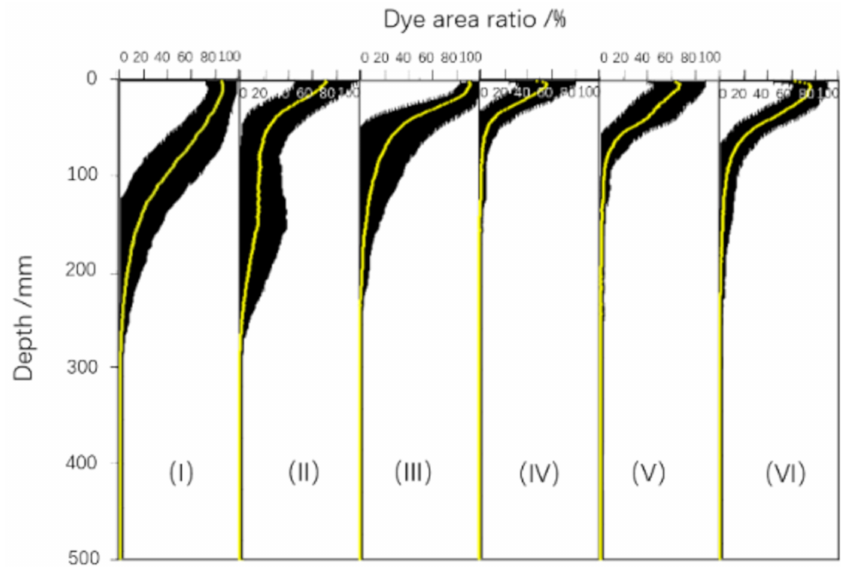
Figure 3. Average of the dyeing area and the standard deviation curve of di ff erent observation plots. (I) corresponds to grassland, (II) corresponds to secondary forestlands, (III) corresponds to Pinus yunnanensis Franch. var. tenuifolia plantation forestland, (IV)